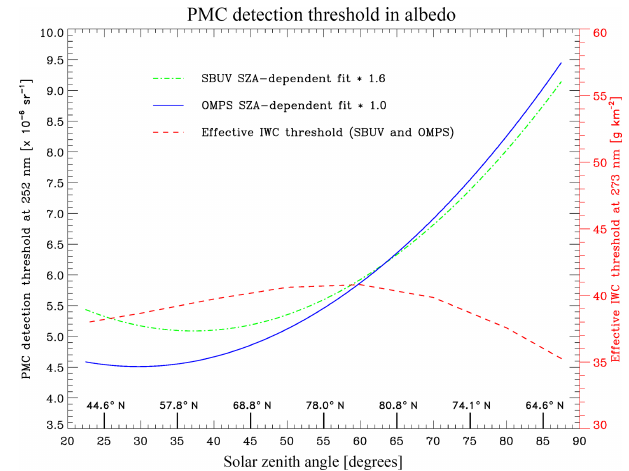
Figure 2. PMC detection threshold functions plotted vs. solar zenith angle (SZA). The quadratic fit in SZA used by DeLand and Thomas (2015) for SBUV/2 processing, derived from NOAA-18 data taken in 2007 on days 222–242, is shown by the dotted–dashed line (green). The quadratic fit in SZA used for OMPS NP data in this paper, derived from S-NPP data taken in 2012 on days 222–242, is shown by the solid line (red). The local time sampling is very similar (13:35LT Equator-crossing time for NOAA-18, 13:40LT Equator-crossing time for S-NPP). The effective IWC threshold (de- scribed in the text) is shown by the dashed line (red) and referenced to the scale on the right-hand y axis. Nominal latitude values for 21 June are identified on the bottom of the plot